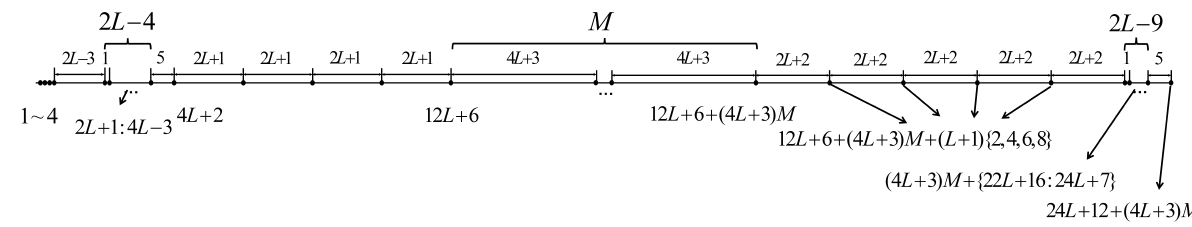
Figure 4. TS2-ENA with visual distribution